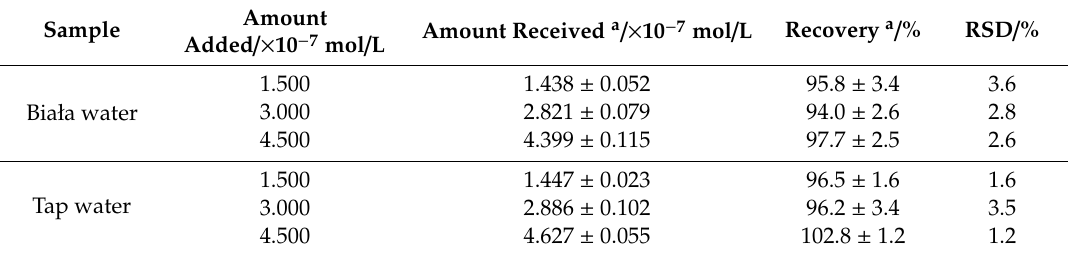
Table 4. Results of posaconazole determination in spiked water